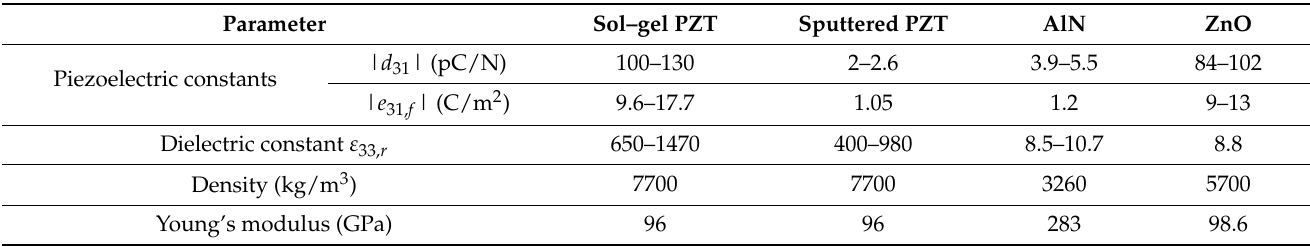
Table 3. Material properties of PZT, AlN, and ZnO piezoelectric thin films [112]. Parameter Sol–gel PZT Sputtered PZT AlN ZnO | d 31 | (pC/N) Piezoelectric constants Dielectric constant ε 33, r Young’s modulus